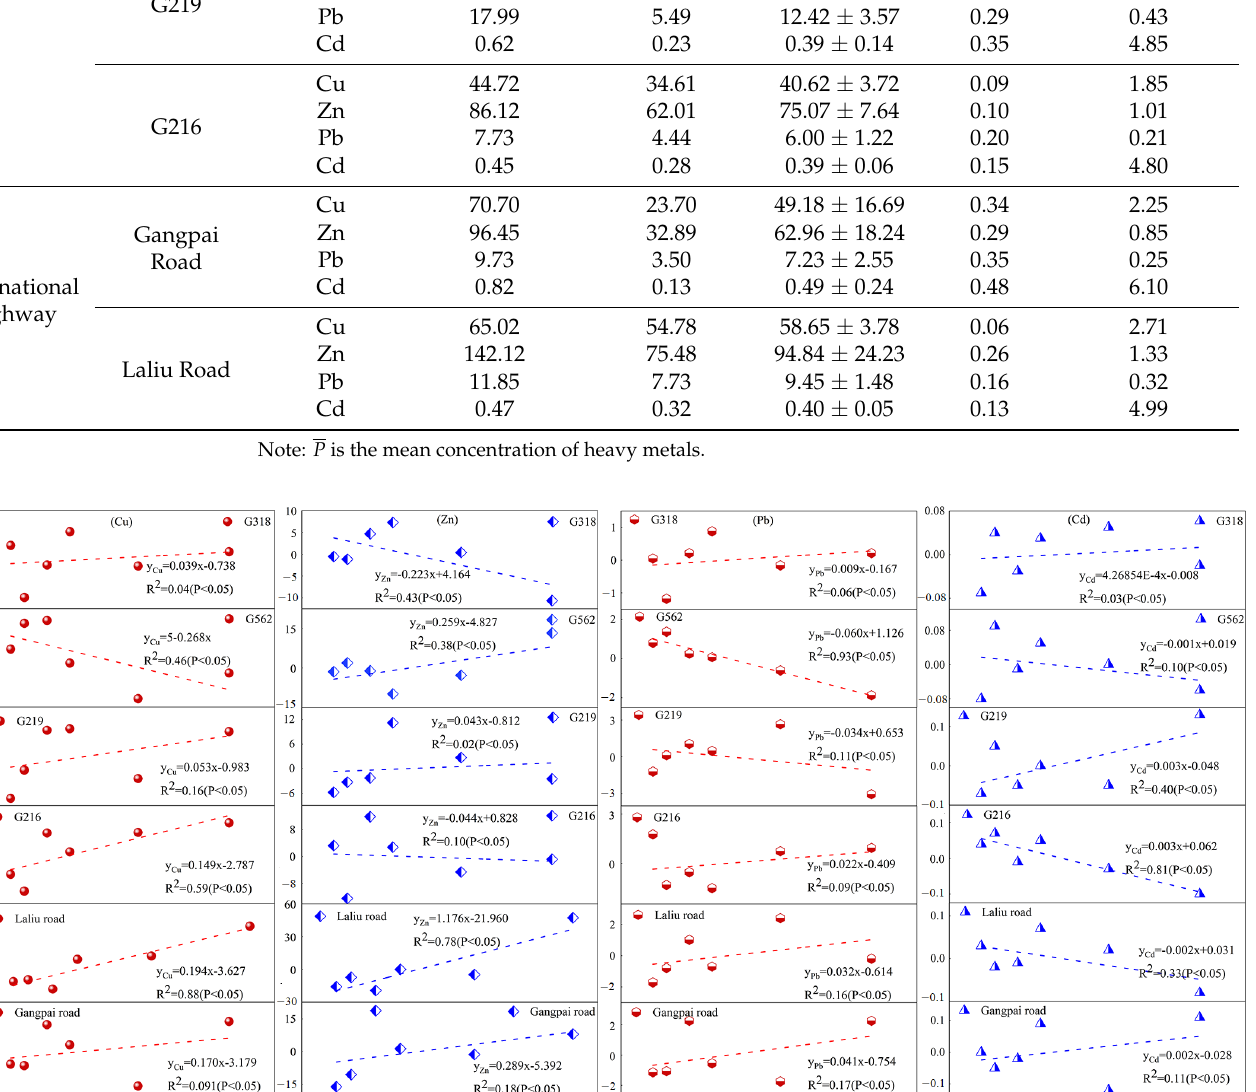
Table 4. Descriptive statistics of soil heavy metal concentrations (mg·kg − 1 ).